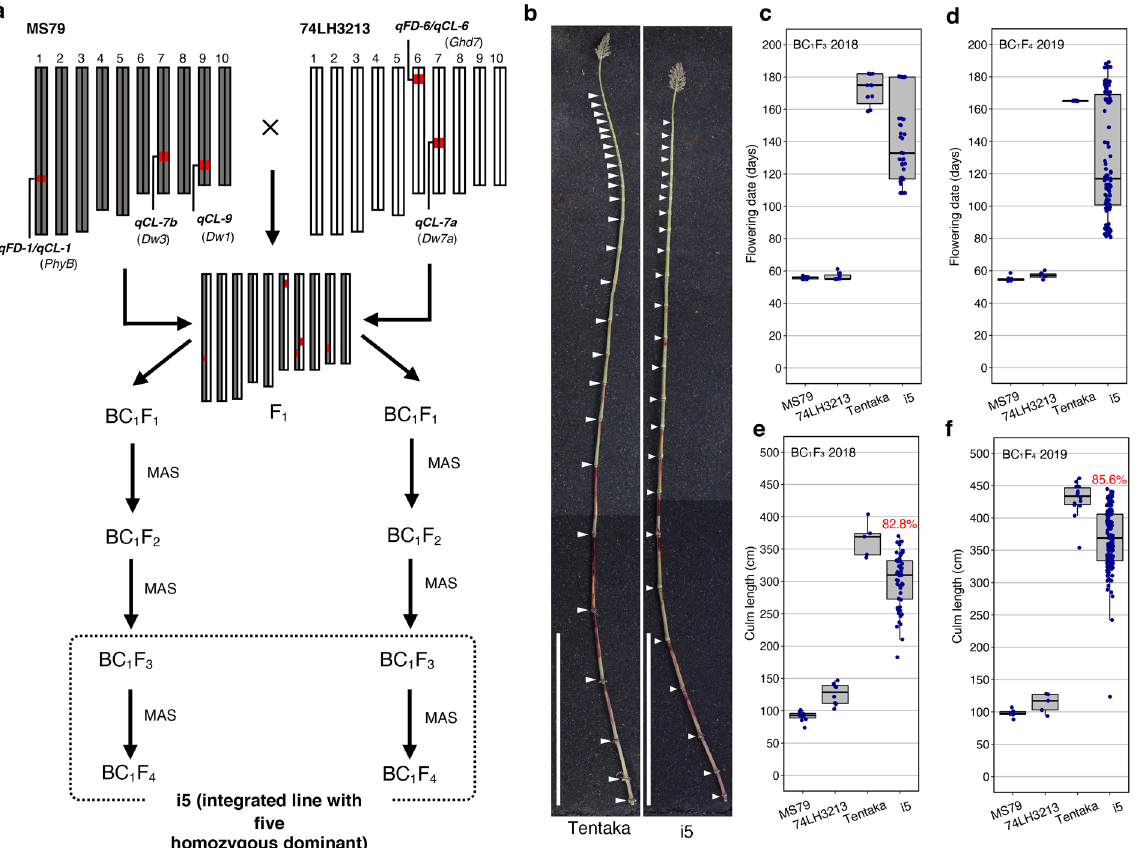
Figure 3. Culm stature of the pyramided lines with five dominant alleles (i5). ( a ) The five dominant alleles ( qFD-1 / qCL-1 , qFD-6 / qCL-6 , qCL-7a/Dw7a qCL-7b/Dw3 , and qCL-9/Dw1 ) were pyramided by backcrossing and self-pollination, resulting in the development of the i5 lines (BC 1 F 3 or BC 1 F 4 ) (for details, see materials and methods). MAS indicates DNA marker-assisted selection for the pyramiding of the five homozygous dominant alleles. ( b ) Elongation patterns for the internode of an F 1 hybrid variety ‘Tentaka’ (left) and the pyramided line with five dominant alleles (i5; right). Scale bar, 1 m. ( c – f ) Flowering date ( c , d ) and culm length ( e , f ) of the MS79 (seed parent), 74LH3213 (pollen parent), Tentaka, and i5. Evaluations of the BC 1 F 3 in 2018 ( c , e ) and BC 1 F 4 in 2019 ( d , f ) are shown. The red numbers in panels ( e ) and ( f ) indicate percentages of the i5 when each score of Tentaka is